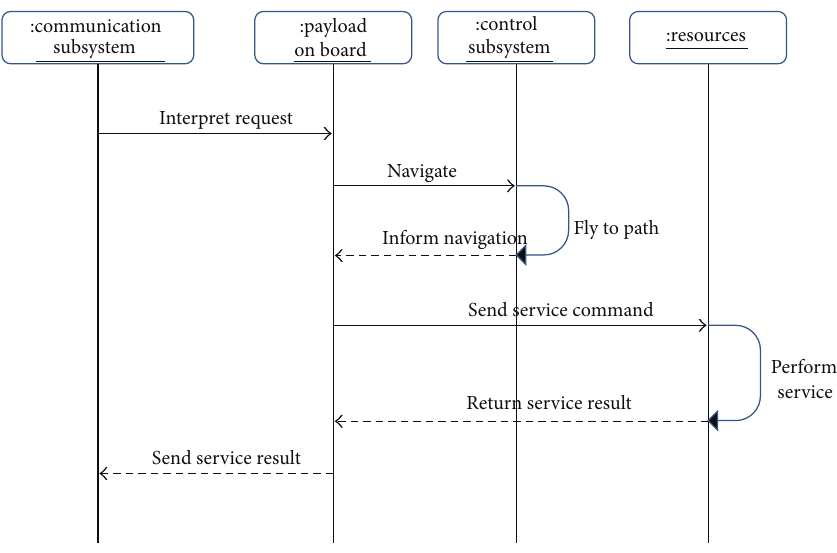
Figure 2: Service request sequence diagram for UAV subsystems.